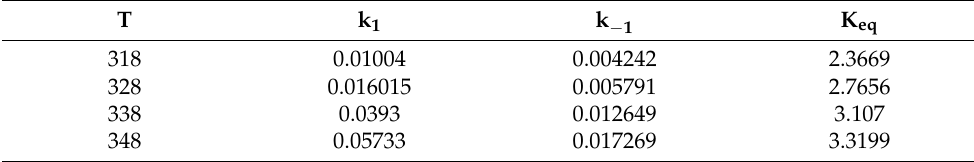
Table 1. k 1 , k −1 and K eq determined at 318, 328, 338 and 348 K.